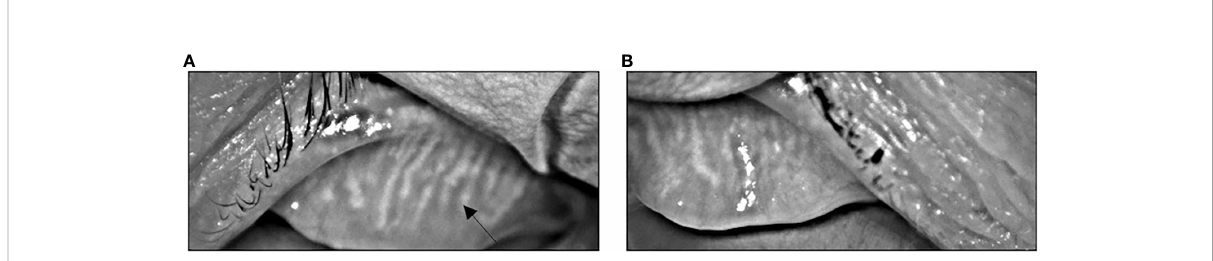
FIGURE 2 Infrared meibography showing atrophy and truncation (arrow) of the meibomian glands of the left (A) and right (B) eyes characteristics of